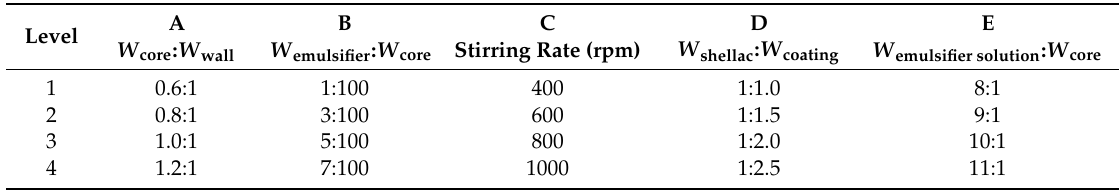
Figure 1. Schematic diagram of melamine formaldehyde (MF)-coated shellac water-based microcapsules. Table 1. Influencing factors and levels.